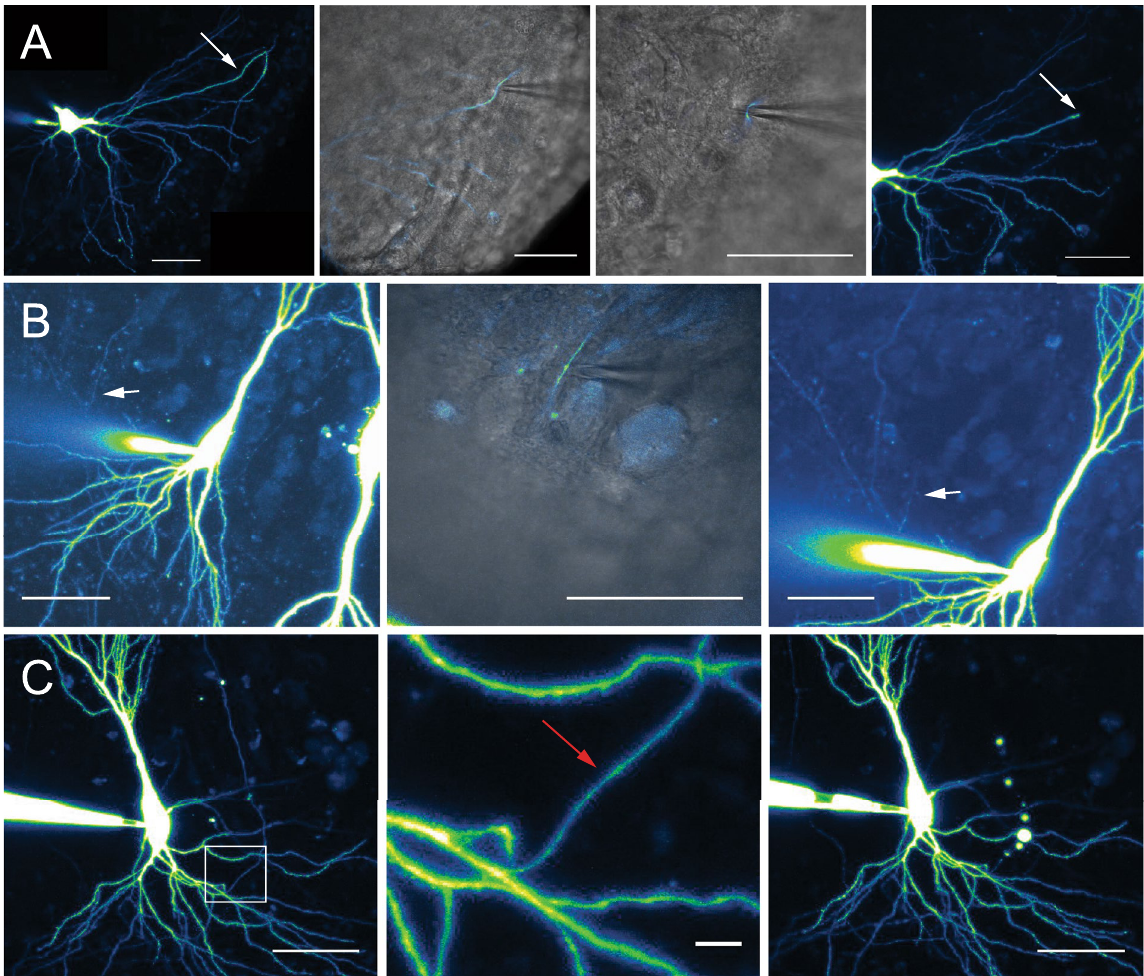
Figure 4. Methods of dendritic and axonal resection and burning. ( A ) Typical dendrite resection. Left panel: after filling a CA3 pyramidal neuron with Alexa 488 50 µ M, dendritic branches could be imaged from apical or basal side of the neuron. Arrow: dendritic branch chosen to be cut. Middle left panel: by using the transmitted light PMT, a second pipette was precisely placed under the selected dendritic branch. Middle right panel: cautiously moving the pipette, it was possible to pull out the dendrite from the slice. Right panel: a brief and strong upward movement results in the dendrite resection, at the point chosen before. Note the absence of Alexa 488 fluorescence downstream of the section. Scale bars: 20 µ m. ( B ) Same protocol applied to axonal branches. Left panel: a collateral crossing the pyramidal layer was chosen. Middle panel: pipette pulling out the axonal branch. Right panel: after section, no fluorescence is visible downstream of the section point. Scale bars: 20 µ m. ( C ) Laser burning of an axon collateral. Left panel: confocal acquisition of a CA3 pyramidal neuron. Middle panel: enlargement of the white box showed in the left panel. The axon is clearly identified as a thin, aspiny process. Red arrow: chosen burning point. Right panel: after cautious burning in line-scan mode, membrane bubbles develop downstream of the burning point, and Alexa 488 staining disappears. No effect can be seen upstream the burning point. Scale bars: 20, 5 and 20 µ